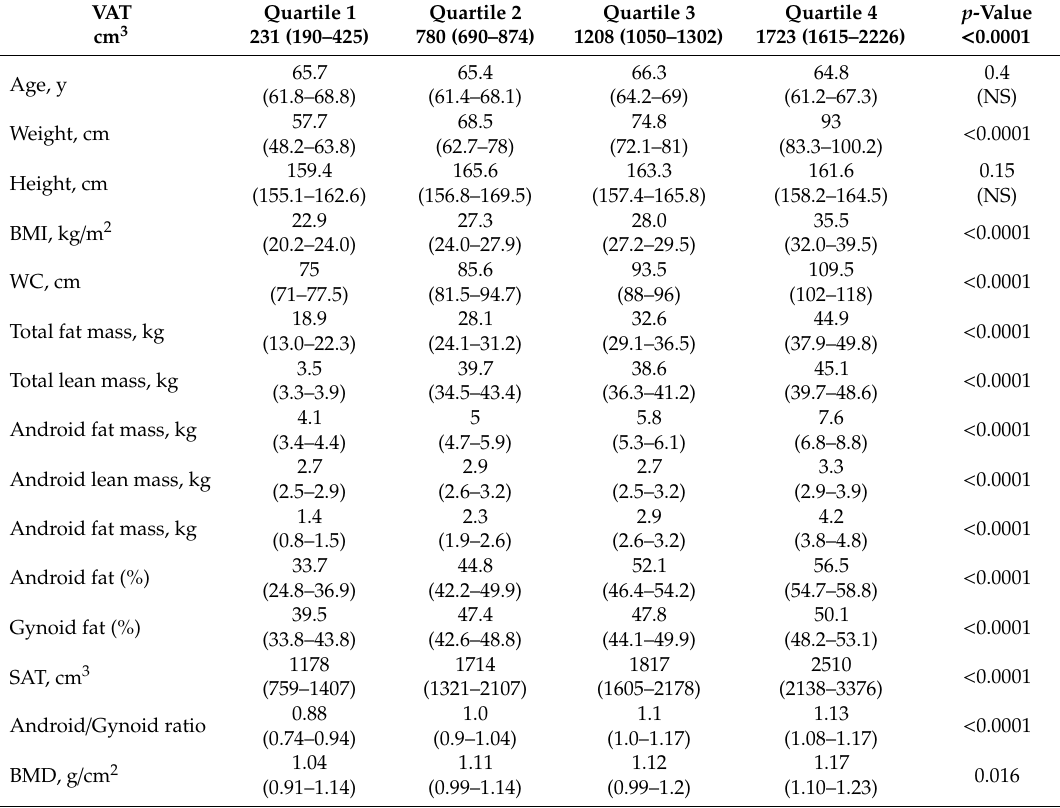
Table 1. Participant characteristics by VAT quartiles; median (interquartile range), n = 19 /